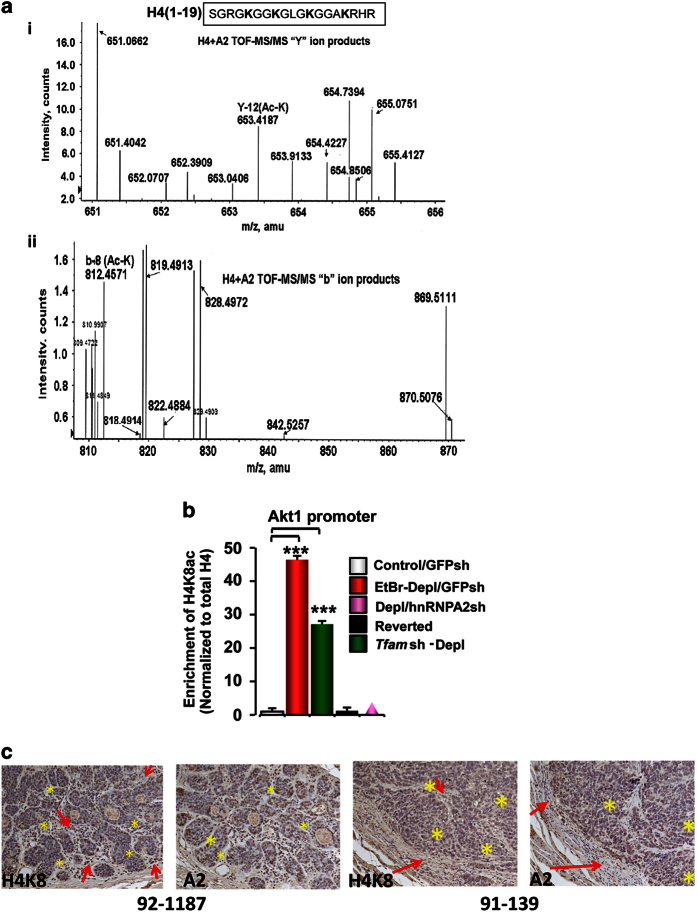
Site specificity of hnRNPA2-mediated H4 acetylation. (a) Identification of
hnRNPA2-specific H4 acetylation sites by LC–MS/MS. The MS/MS spectrum of peptide
1SGRGKGGKACGLGKGGAKRHR19 confirms K8 acetylation. (i)
Y-ion products. The peak at m/z 653.41 (labeled Y-12) corresponds to
acetyl lysine; (ii) b-ion products. The peak at m/z 812.45 (labeled
b-8) corresponds to acetyl lysine. (b) ChIP assay showing enrichment of H4K8
acetylation at the Akt1 promoter in control, PmtDNA-depl, PmtDNA-depl/hnRNPA2sh
and reverted C2C12 cells. Antibodies specific to H4K8Ac, was used for
immunoprecipitation. Rabbit IgG and H4K5ac antibody were used as negative antibody
controls and β-actin promoter was used as a negative control for promoter DNA
region (Supplementary Figure S3A–C). Data are
represented as mean±s.d. (c) Immunohistochemistry of serial sections of
esophageal squamous cell carcinoma from two representative patient samples stained with
either acetyl-H4K8 or hnRNPA2 antibody as indicated in the figure and described in
Supplementary Information. The * shows stained tumor cells
and the red arrows indicate the stroma. Patient case numbers are indicated in the
figure.